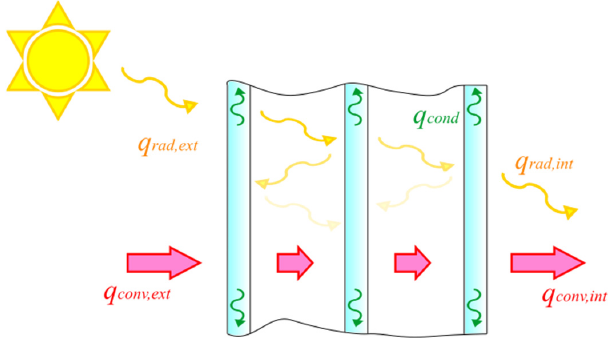
Figure 4. Schematics of the heat exchange phenomena occurring in an IGU.